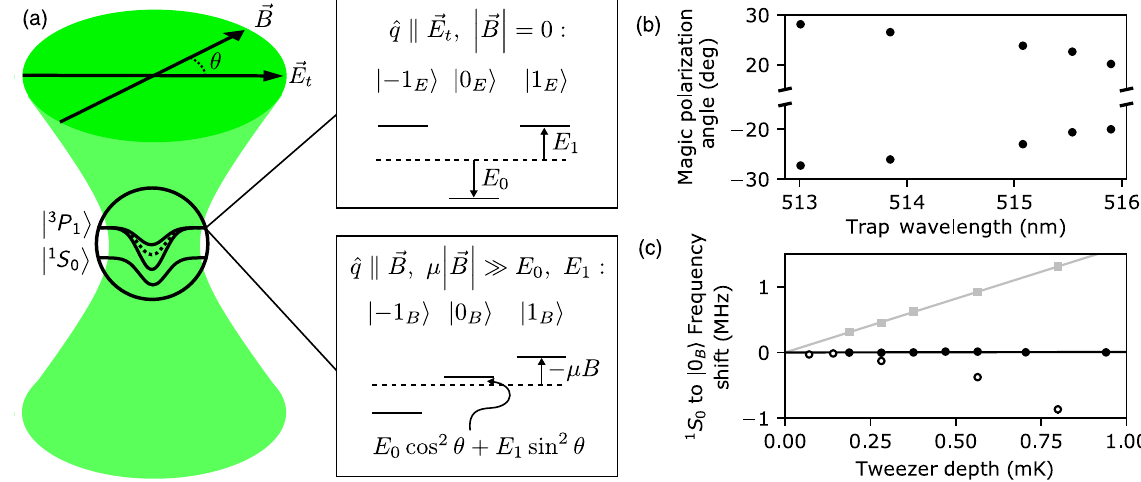
⃗ B FIG. 2. Magic polarization angle. (a) By setting the angle θ between an applied magnetic field ( ) and the polarization of the tweezer ⃗ E ), we can achieve equal trap depths between the ground ( 1 S 0 ) and an optically excited ( 3 P 1 ) state. In the absence of a magnetic light ( t field, the tweezer light causes energy shifts to the different spin projections of 3 P 1 . These shifts are of opposite sign relative to the shift of the ground state (dashed lines denote the shifted ground state offset by the unperturbed transition frequency). By applying an i for which these shifts cancel, leading to state-insensitive trapping. appropriately oriented magnetic field, we can create an eigenstate j 0 B i transition is unperturbed by the tweezer depth (for We define the “ magic ” polarization angle θ for which the frequency of the 1 S 0 to j 0 B sufficiently low depths relative to the field strength). Full details are provided in the main text. (b) Magic polarization angle as a function i transition as a of tweezer wavelength, showing that a magic condition exists over a range of wavelengths. (c) Shifts of the 1 S 0 to j 0 B function of tweezer depth for a large (22 G) field oriented at θ ≃ 0 (gray squares), a large (24 G) field oriented at the magic angle (black points), and a small (7 G) field oriented at the magic angle (empty circles). All data in (c) are at a tweezer wavelength of 515.13 nm. Gray and black lines are linear